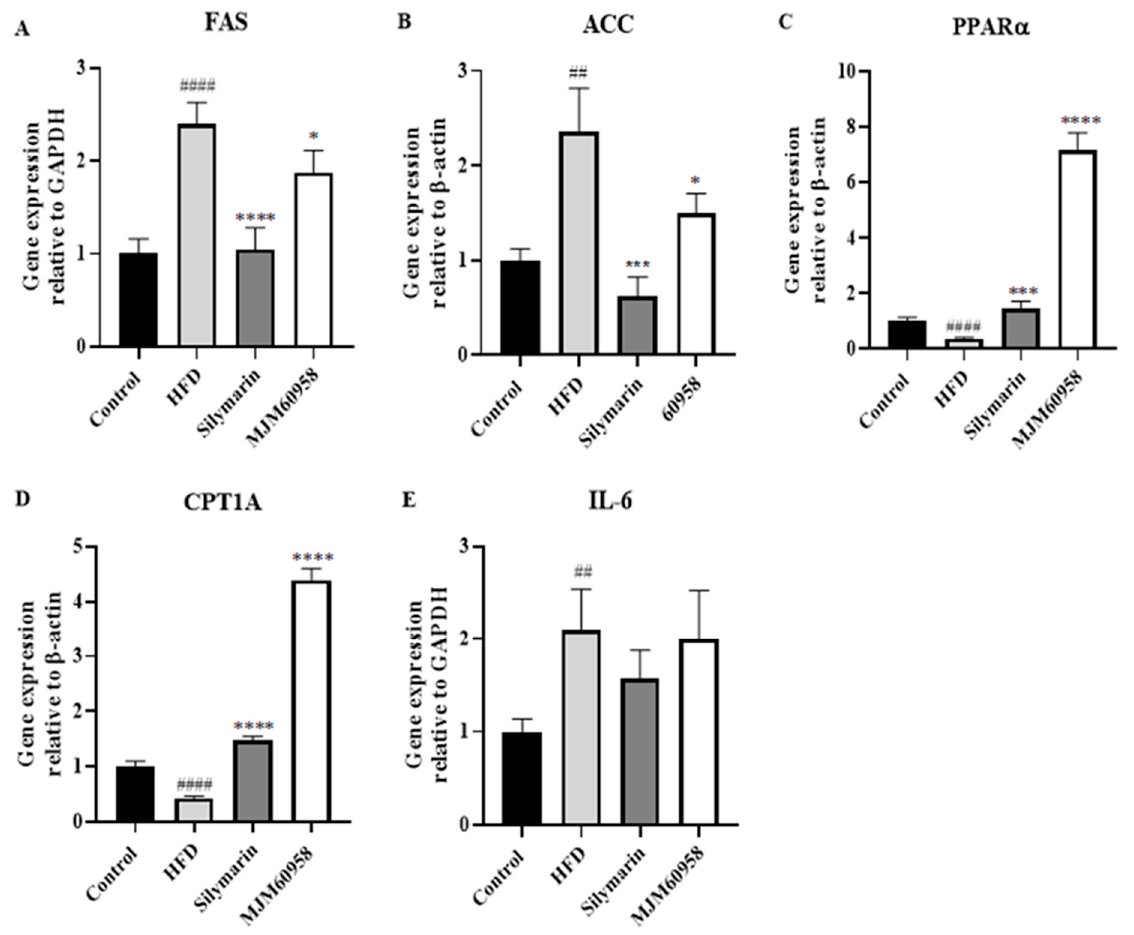
Figure 5. Effect of L. sakei MJM60958 on the mRNA expression of liver tissues in mice after 12 weeks of treatment. mRNA of ( A ) FAS, ( B ) ACC, ( C ) PPAR α , ( D ) CPT1A, and ( E ) IL-6 were quantified using qRT-PCR. Data are expressed as the means ± standard deviation of triplicate independent experiments. ## p < 0.01, #### p < 0.0001 compared with control group; * p < 0.05, *** p < 0.001, **** p < 0.0001 compared with HFD group.